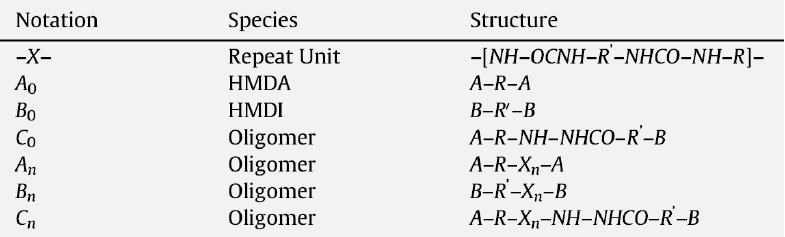
Figure 48. Effect of the monomer mole ratio of HMDI to HMDA (R) on process kinetics (n L /V d = 0.545 kmol/m 3 ). From reference [70]. The storage of energy can be associated with Phase Change Materials (PCMs), which can store as well as release energy from or to the surroundings during these changes. The quantity of energy per weight of the material is so large that a lower volume is required by the system to facilitate these energy exchanges. In addition, during the phase change, the temperature remains nearly constant, which is beneficial for the control of the tem- perature of the surroundings. In the case of interfacial polycondensation (IP) materials such as polyurea, polyurethane, polyester, polyamide and amine resin, these can be used as shell monomers in the interfacial polycondensation process. The core materials are made into droplets. The capsule shell reactive monomers polymerize on the surface of the droplets. When the initially formed oligomers are insoluble at the interface of the droplets, they grow, and a thin monolayer membrane forms around the droplets. The polycondensation causes the monolayer membrane to be a shell and finally leads to the formation of a microscopic shell around the droplets [73]. In particular, urea-based compounds, due to their excellent hydrogen bonding ca- pabilities, are well known for templating the organization of the functional groups that can result in interfacial polycondensation in sheets or lamella structures [34]. PUs syn-